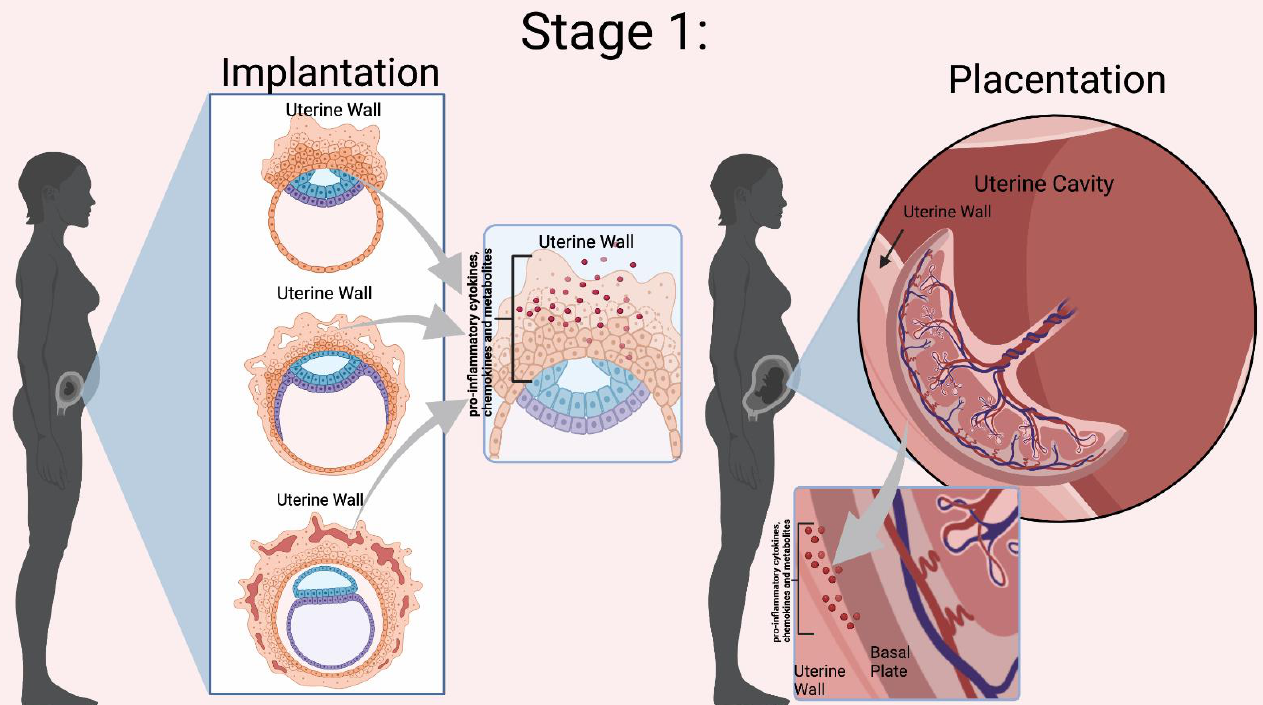
Figure 2. Mor et al. Stage 1 of Immunological Events Occurring During Pregnancy. Implantation relies on the presence of pro-inflammatory cytokines, chemokines, and other mediators to invade the uterine wall [10]. During placentation there is a dynamic relationship between the uterine wall and the placenta for trophoblast differentiation and proper placental development. Inflammation is indicated by the red dots in the Figure. Figure created in BioRender.